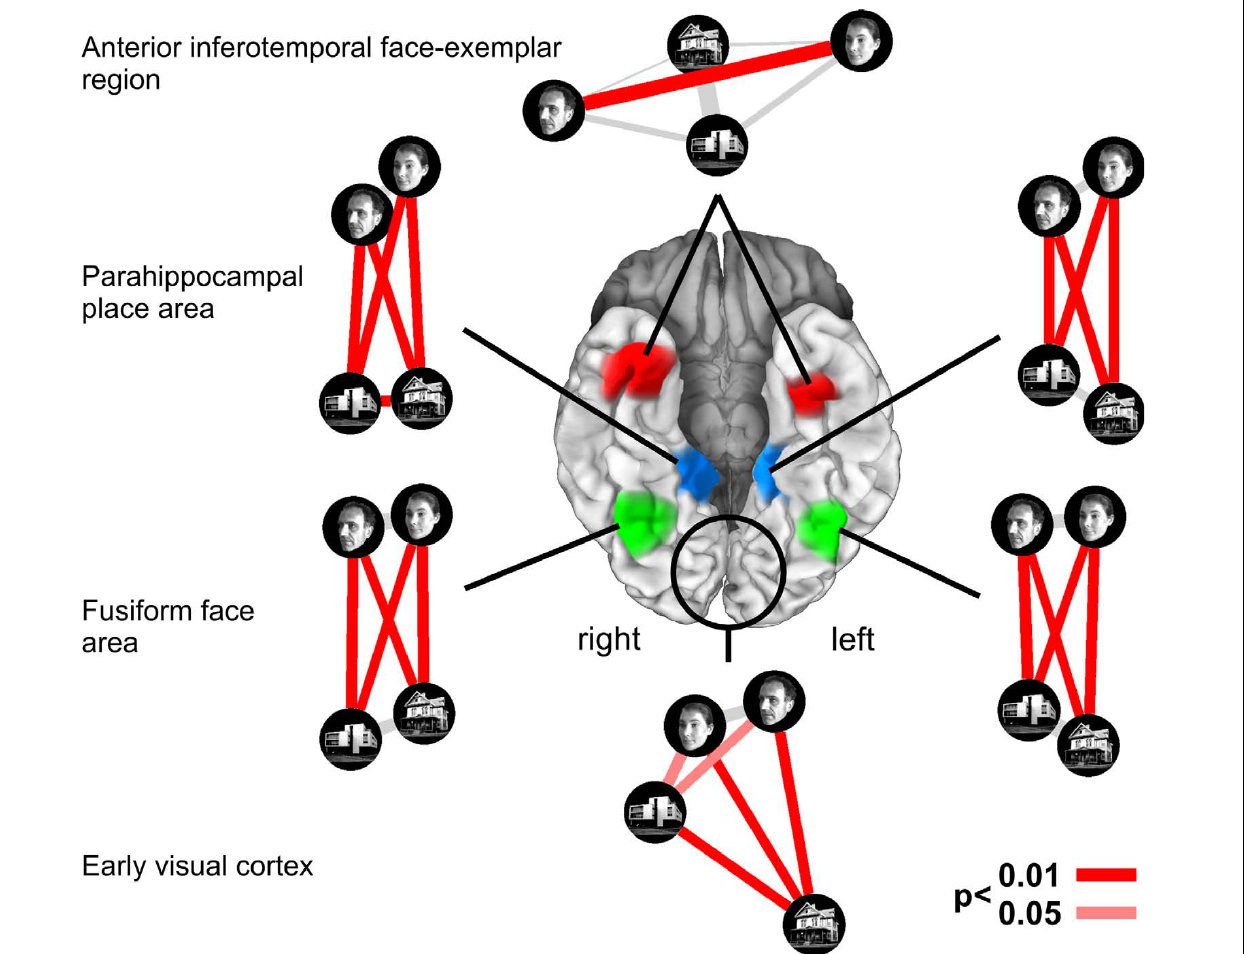
FIGURE 1 | Characterizing brain regions by representational similarity structure . For each region, a similarity-graph icon shows the similarities between the activity patterns elicited by four stimulus images. Images placed close together in the icon elicited similar response patterns. Images placed far apart elicited dissimilar response patterns. The color of each connection line indicates whether the response-pattern difference was signifi cant for the group (red: p < 0.01; light gray: p ≥ 0.05, not signifi cant). A connection line, like a rubberband, becomes thinner when stretched beyond the length that would exactly refl ect the dissimilarity it represents. Connections also become thicker when compressed. Line thickness, thus, indicates the inevitable distortion of the 2D representation of the higher-dimensional similarity structure.